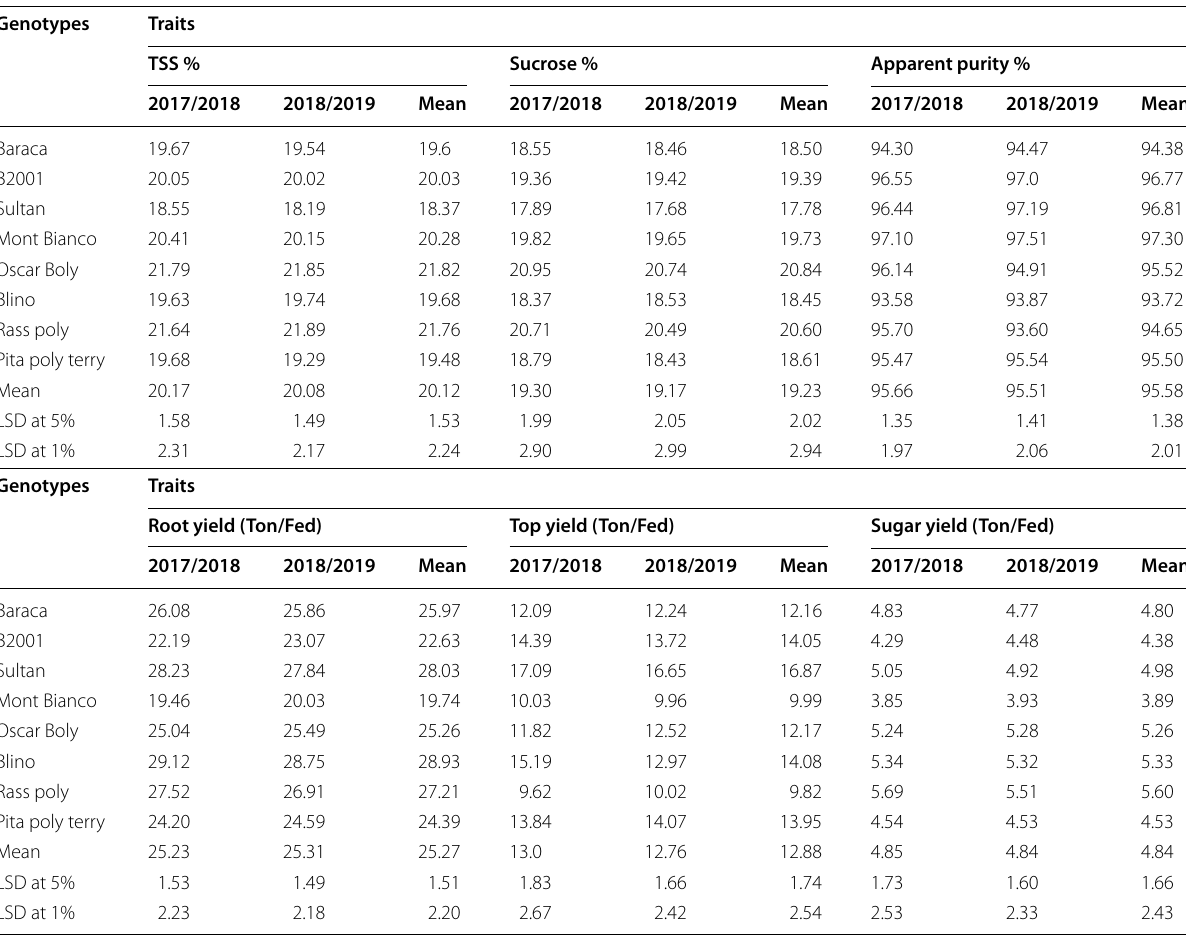
Table 4 Mean Performance and Combined Analysis for All Studied Traits of the eight sugar beet accessions in the two